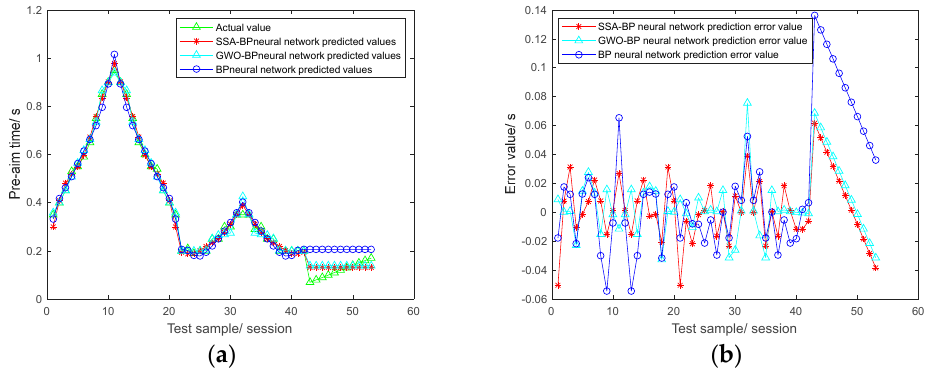
Table 1. Performance comparison of different pre ‐ aim time regulators.